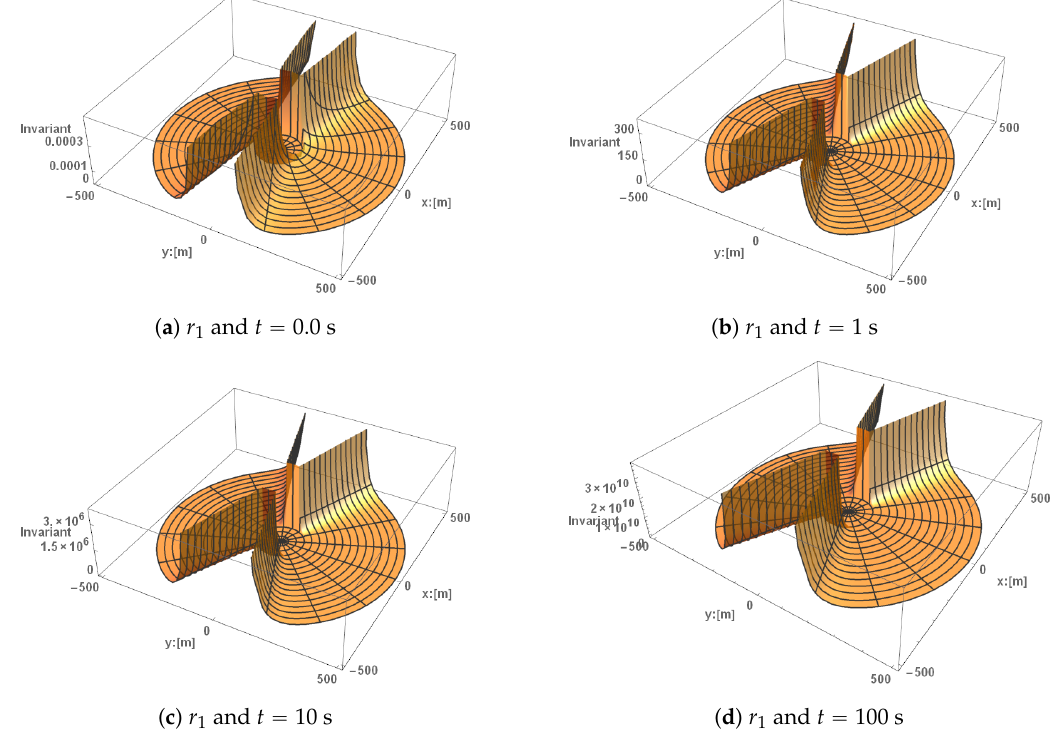
Figure A1. The time, t , of the invariant r 1 is plotted in the figures above. The other parameters were set to be σ “ 50,000 m ´ 1 , ρ “ 100 m, and a “ 1.0 m s ´ 2 . The plots were rendered using Mathematica’s ® RevolutionPlot3D. It plots a function by rotating the function around the z-axis. The amount that the space diverges from being flat is represented by the invariant function’s magnitude, and its amount is labeled on the vertical axis. The x and y-axis are displayed on the plots, and they display the distance from a spaceship in the flat portion at the center of each figure. Each radial line in the plot corresponds to a distance of approximately 33 m. The constant portion to the right of the harbor is to the front of the warp bubble, and the constant portion to the left of the harbor is the back of the warp